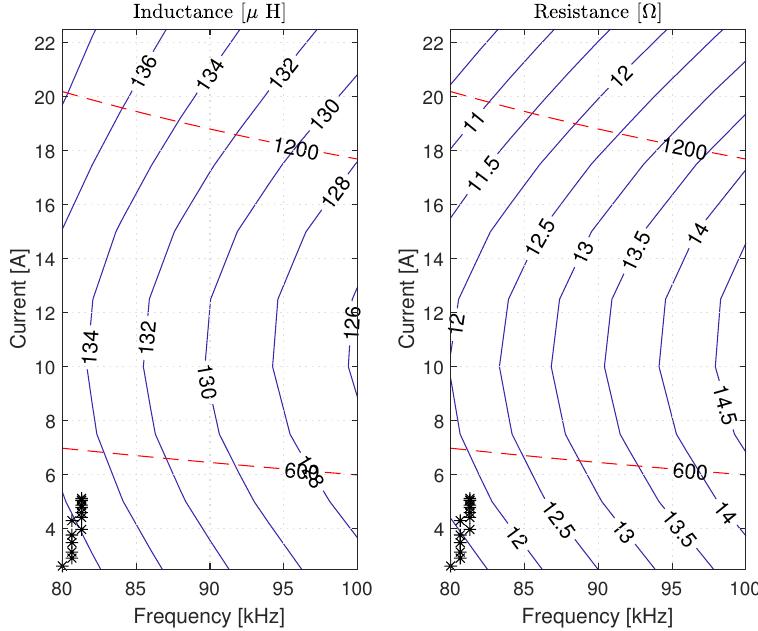
Figure 10. RL maps with safe operative limit constraints (red dotted lines) representing the maximum collector–emitter voltage on the diode and the operation area of the converter (black